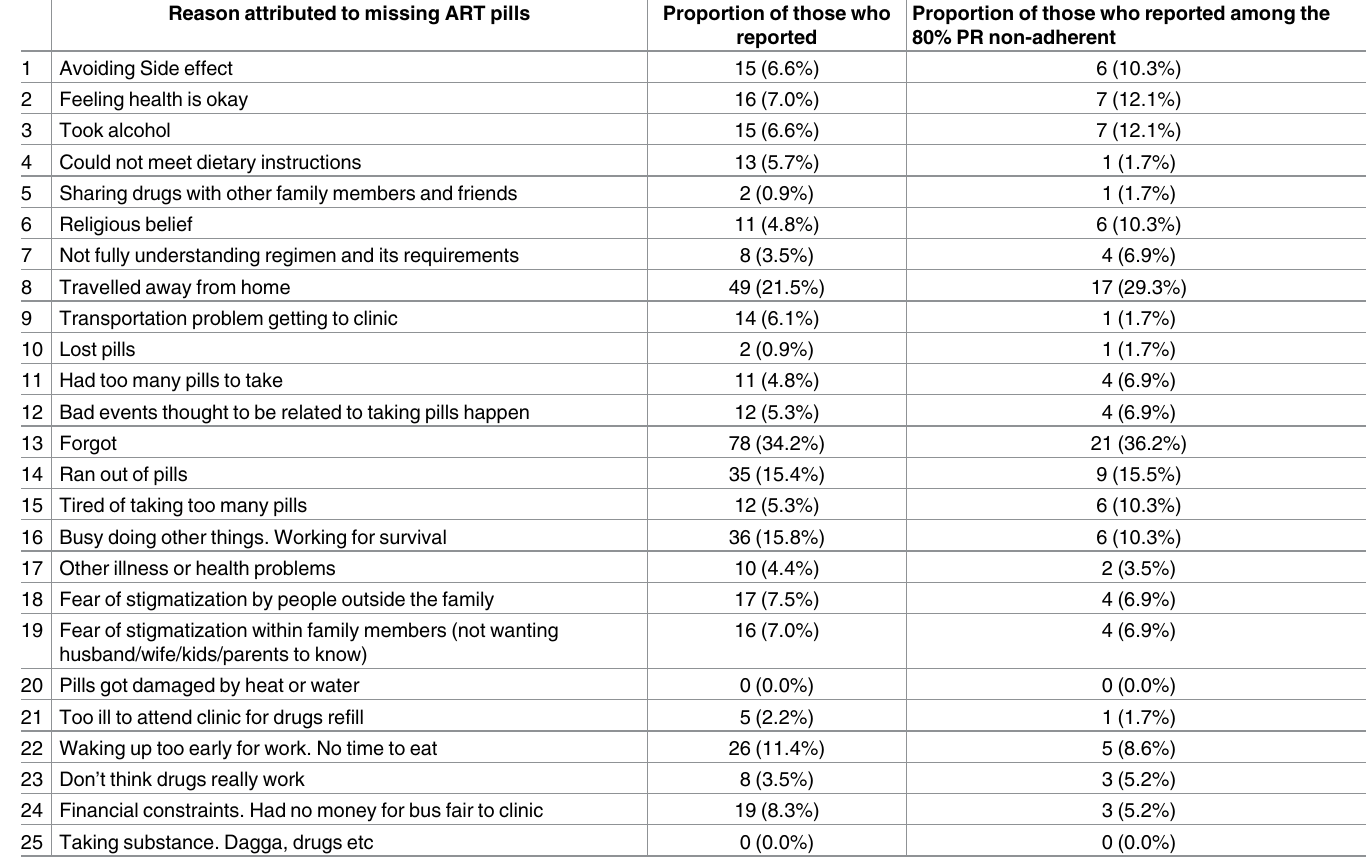
Table 6. Patient self-reported reasons for missing ART pills three months preceding the